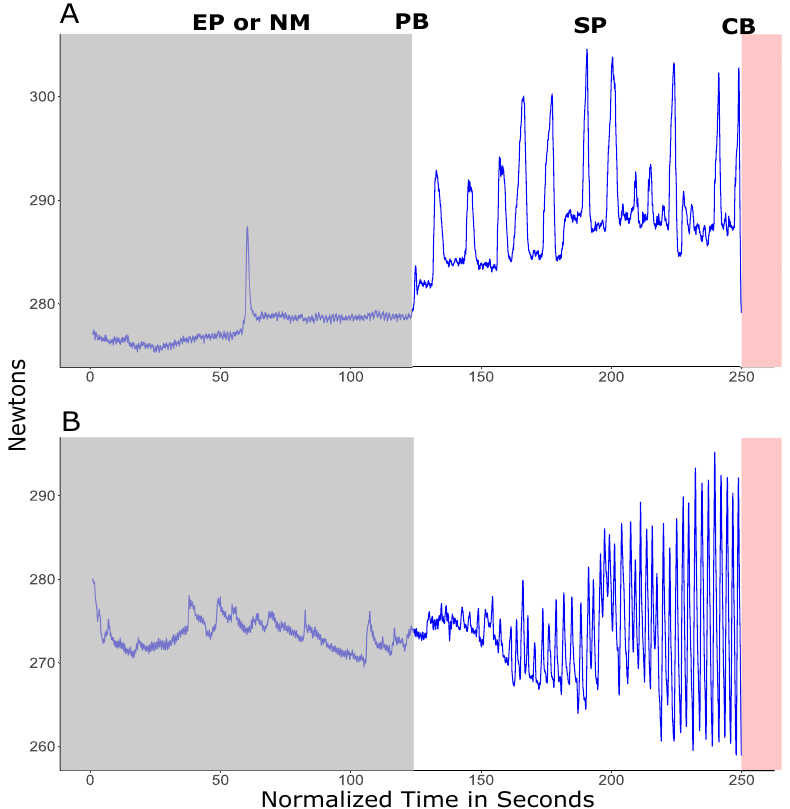
Figure 6. Raw force signal during BH. The top panel ( A ) and bottom panel ( B ) show force signals for two different participants. The x-axis is the normalized time in seconds. The time was normalized across participants for better visual representation. The y-axis is the force magnitude in newtons, which was not normalized here. The gray region shows NM (or the easy phase (EP)), the white region shows SP, and the red region, starting from the CB, shows the end of BH. The spikes appearing during BH are movement artifacts due to some position changes on the force plates, which were later removed from the analysis. ( A ) The force signal for a participant displaying a slight decrease in amplitude near the end of SP. ( B ) The force signal for a participant showing continuously increasing amplitude until the end of